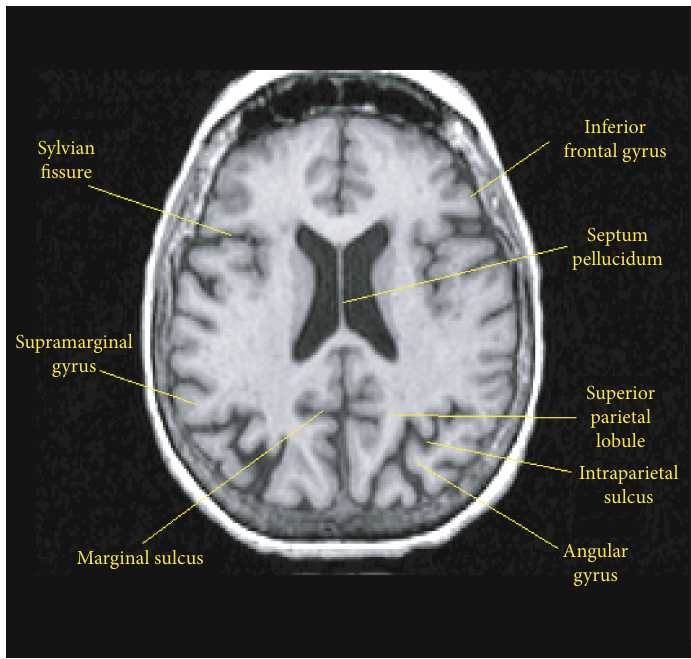
Figure 2: Normal axial